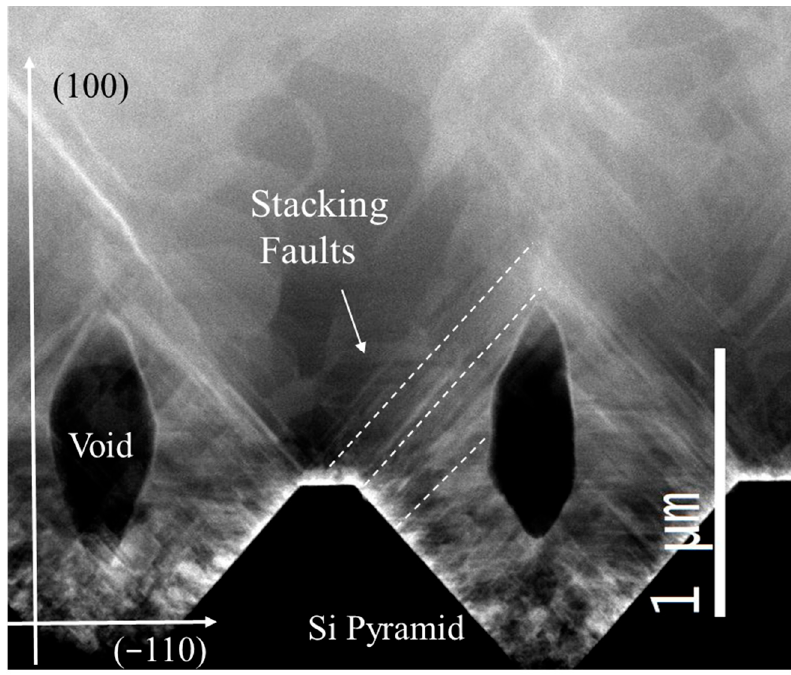
Figure 6. TEM plan view of a 12 µ m-thick sample. Stacking faults are indicated together with major crystallographic directions. Si pyramid, voids, and SFs are indicated. 270